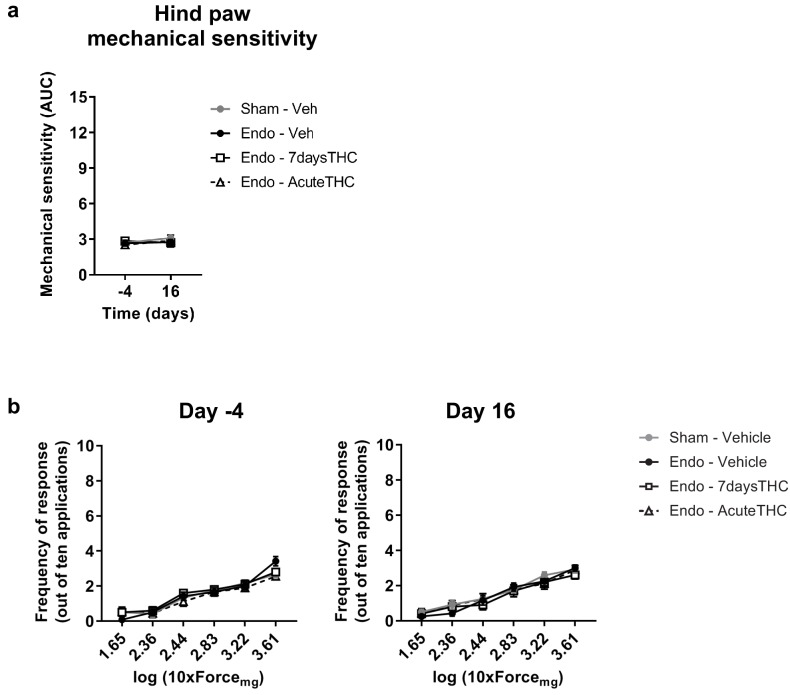
Effect of a repeated THC treatment starting on day eight after surgeries on nociceptive responses to hind paw mechanical stimulation with von Frey filaments.(a) Mechanical sensitivity in the hind paw remained stable after endometriosis surgery or THC treatment. Mechanical sensitivity is represented by the area under the curve of frequency of response to von Frey filaments. Higher values mean higher mechanical pain. (b) Similar frequency of responses was observed in all groups of mice before and after the surgery. THC dose: 2 mg/kg/day. Error bars are mean ± SEM. Mixed model + Bonferroni. Endo, endometriosis; THC, Δ9-tetrahydrocannabinol, AUC, area under the curve.